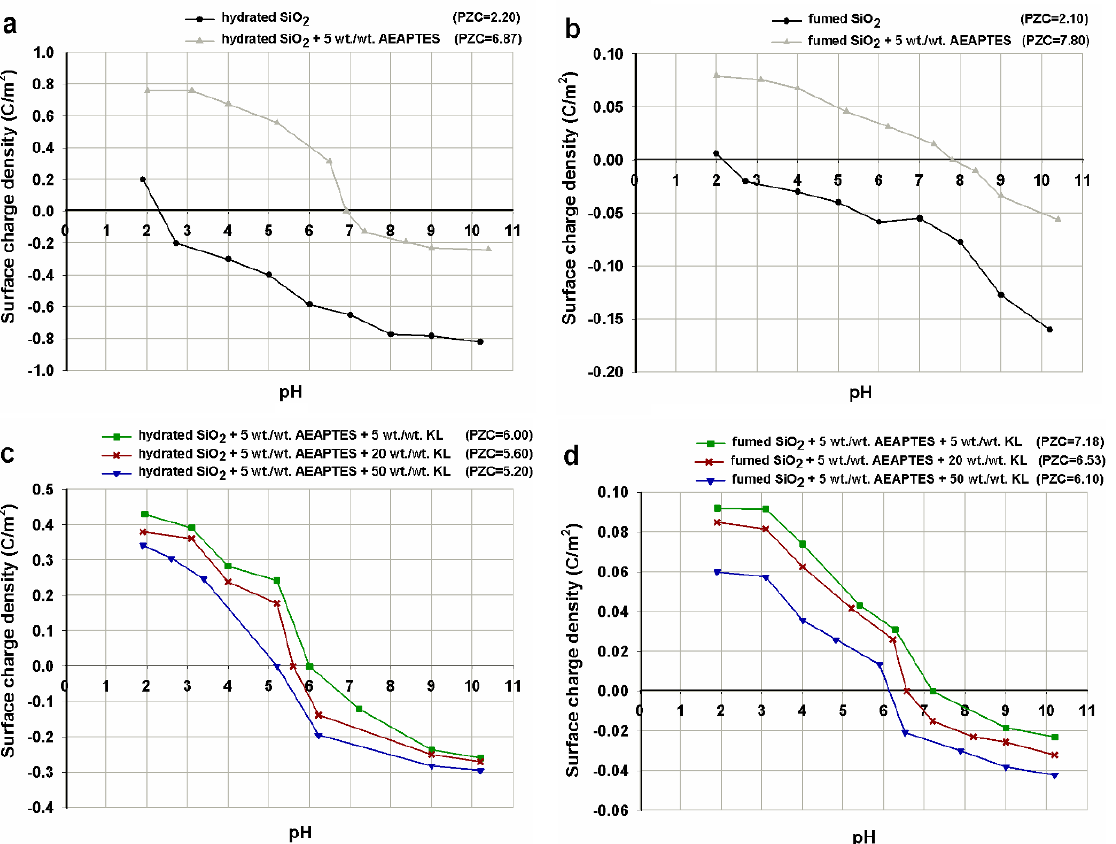
Figure 9. Surface charge density as a function of pH for unmodified and modified silicas (a, b), and silica/lignin hybrids obtained from hydrated silica (c) and Aerosil ® 200